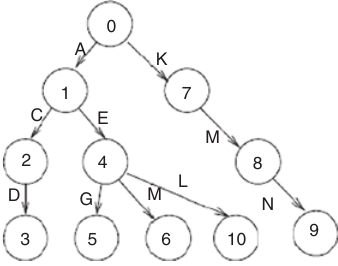
Figure 1: Trie Data Structure [2].